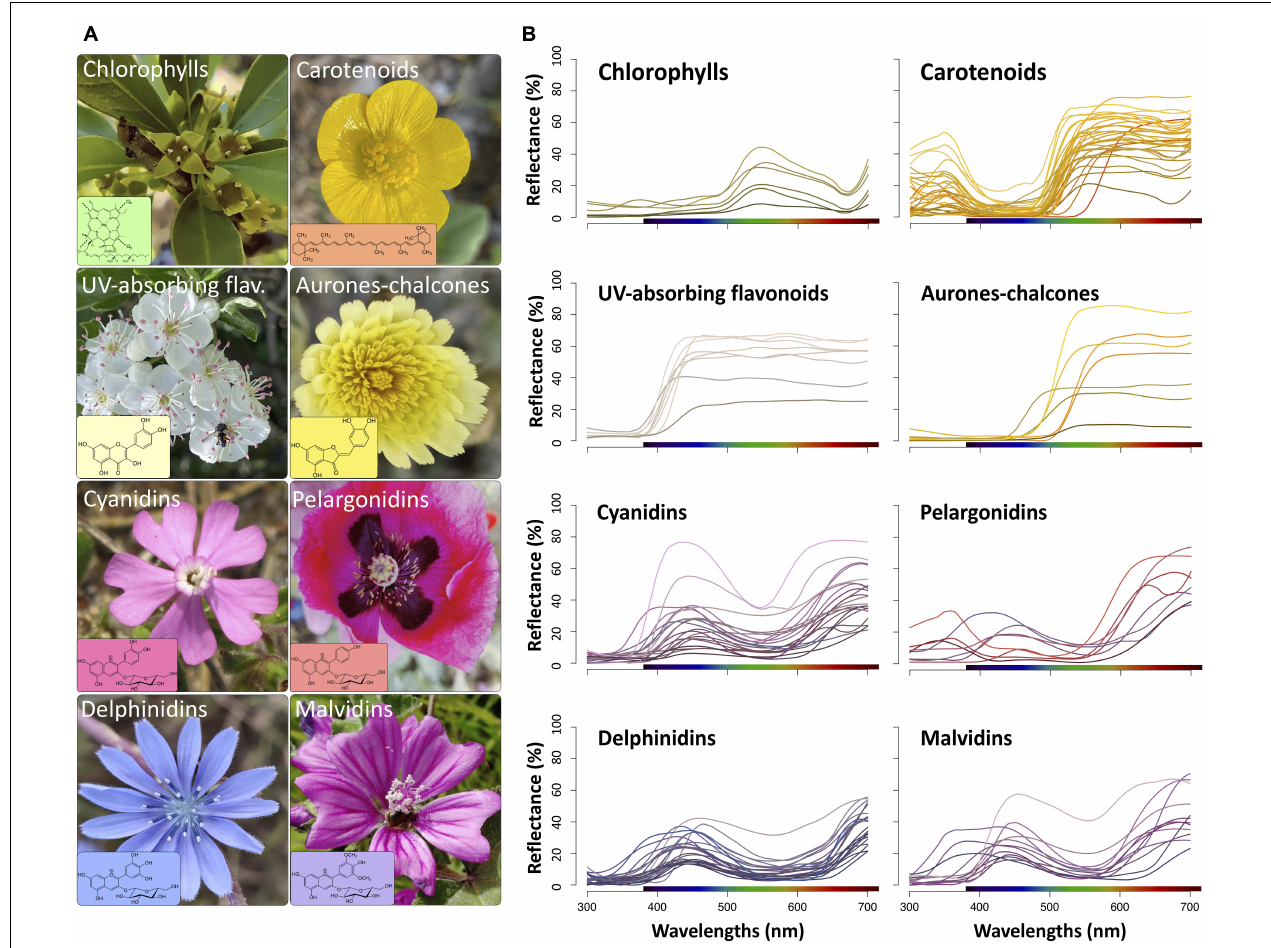
FIGURE 1 | (A) Examples of species with flowers containing one of the main groups of pigments considered in this study and its molecular structures (in the boxes). Rhamnus lycioides (Rhamnaceae), chlorophylls; Ranunculus acris (Ranunculaceae), carotenoids; Crataegus monogyna (Rosaceae), UV-absorbing flavonoids; Andryala integrifolia (Asteraceae), aurones-chalcones; Silene littorea (Caryophyllaceae), cyanidins; P. somniferum (Papaveraceae), pelargonidins; Cichorium intybus (Asteraceae), delphinidins; Malva sylvestris (Malvaceae), malvidins. The colour of the box represents the approximate colours producing in flowers based on human vision model. (B) Reflectance spectra of all species used in this study grouped by types of flower pigments. The colour of each spectral line represents the flower colour based on human vision model.